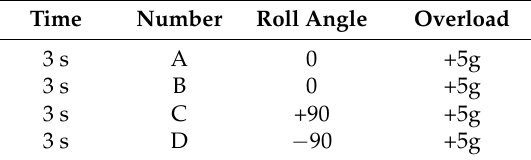
Table 8. Maneuver description.